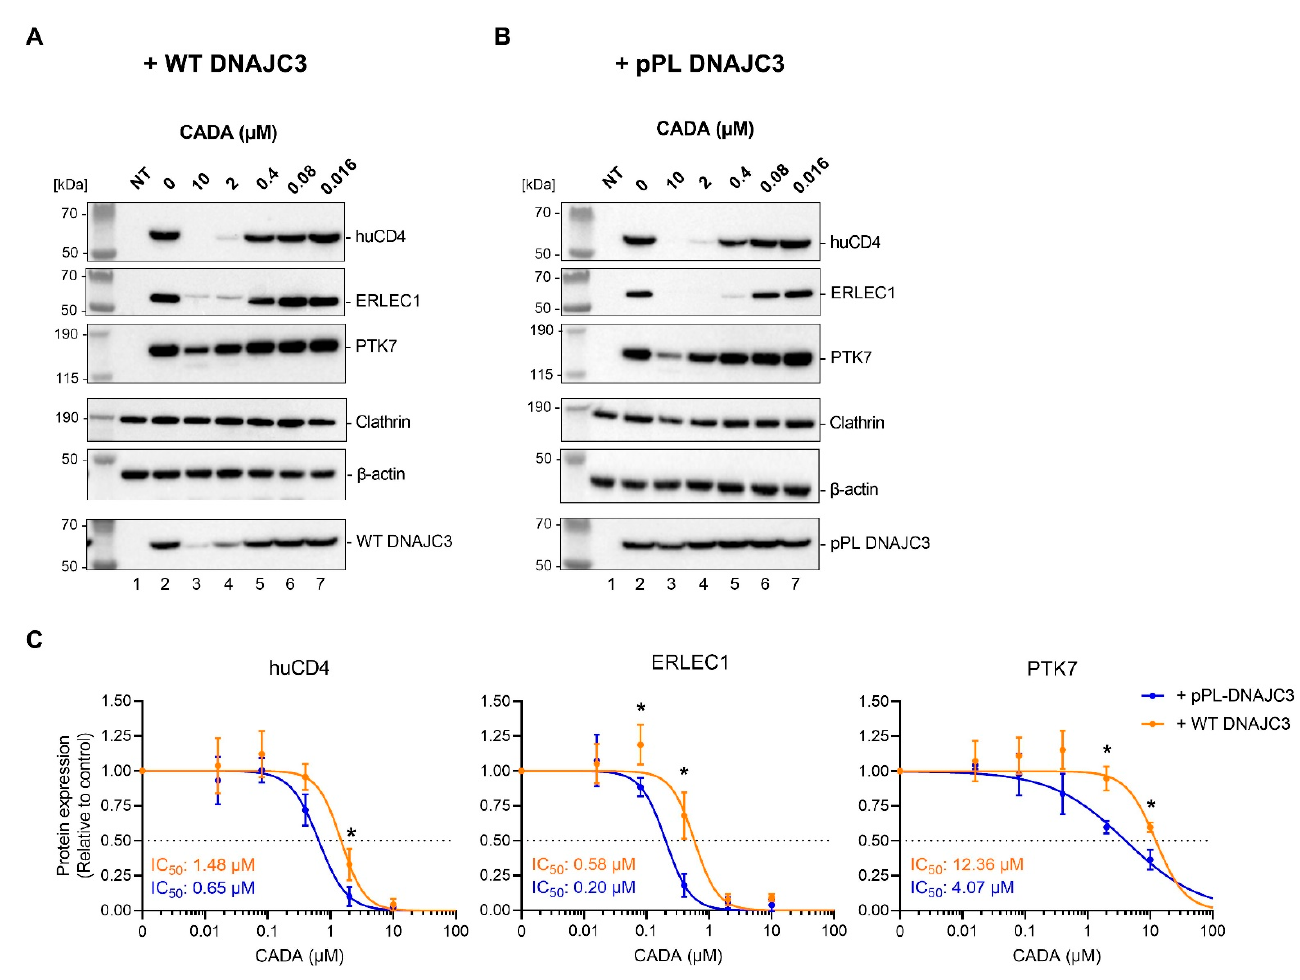
Figure 3. DNAJC3 sensitizes targets to CADA. ( A ) Western blot images of cell lysates from non- transfected (NT) HEK293T cells, and huCD4-V5, ERLEC1-V5 or PTK7-V5, co-transfected with WT DNAJC3. Cells were treated for 24 h with different CADA concentrations and subjected to im- munoblotting. Protein bands were visualized with an antibody against the V5 tag, and an antibody against clathrin (huCD4 and ERLEC1) or β -actin (PTK7) was used for the cell loading controls. An antibody against the FLAG tag was used to detect the co-transfected WT DNAJC3 in the samples. One representative experiment out of three to six is shown. The clathrin loading control shown is that of the ERLEC1 sample. The respective loading control for huCD4 and WT DNAJC3 is presented in Supplementary Figure S3D. ( B ) Same as in ( A ) but for co-transfection with pPL-DNAJC3. One representative experiment out of three to six is shown. The clathrin loading control shown is that of the huCD4 sample. The respective loading control for ERLEC1 and pPL-DNAJC3 is presented in Supplementary Figure S3D. ( C ) Concentration–response curves of CADA for huCD4, ERLEC1 and PTK7 in transfected HEK293T cells. Samples from ( A , B ) were quantified and normalised to the clathrin (huCD4 and ERLEC1) or β -actin (PTK7) internal control. A four-parameter concentration– response curve was fitted to data from at least three replicate experiments. Values are mean ± SD; n ≥ 3. Statistical analysis (multiple unpaired t -tests) showed significantly decreased expression of huCD4, ERLEC1 and PTK7 when co-expressed with pPL-DNAJC3 as compared to WT DNAJC3 (* = p < 0.05). HEK293T: human embryonic kidney 293T cells; huCD4: human CD4; ERLEC1: endo- plasmic reticulum lectin 1; PTK7: inactive tyrosine-protein kinase 7; pPL: pre-prolactin; DNAJC3: DnaJ homolog subfamily C member 3; CADA: